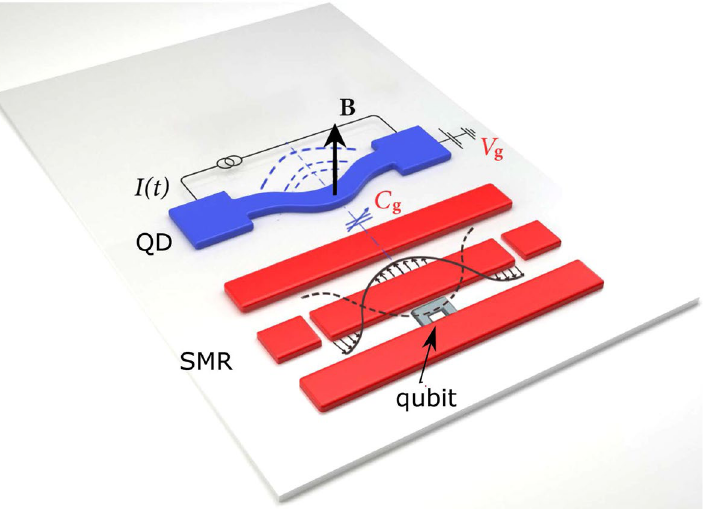
Figure 1. Schematics of the discussed circuit-QED-based realisation of the considered hybrid optomechanical system. It consists of a superconducting qubit embedded in a superconducting microwave resonator (SMR), e.g., a transmission-line resonator, to induce its nonlinearity. A quantum micromechanical resonator, which is referred to as a quantum drum (QD), is coupled to the SMR with a tunable capacitor C g . We assume that the system is driven either at the SMR or QD. Dashed semicircular curves visualise that the QD is oscillating. The driving and motion detection of the QD can be realised by controlling the static magnetic field B , potential V g , and alternating current I ( t ), as described in Ref. 47 for detecting phonon